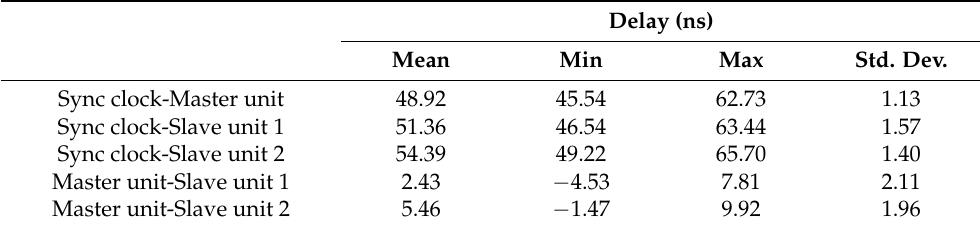
Table 2. Measured delays between sync and sampling